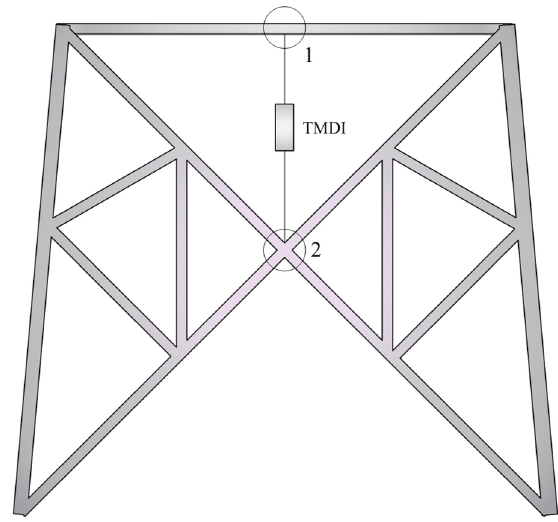
Figure 1. Part of the structure of the transmission tower. The structural configuration of the system is shown in Figure 2.